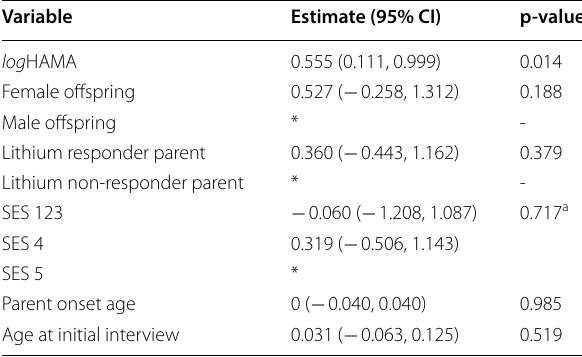
156) with 95% confidence interval =